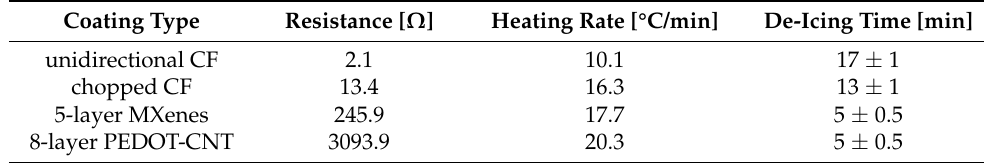
Table 1. De-icing time of different coatings at the same power density of 0.088 W/cm (7.44 W). Coating